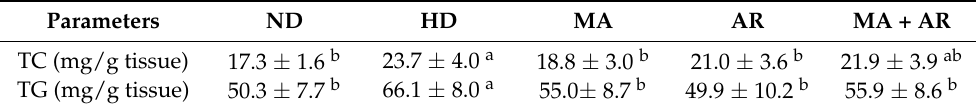
Table 3. The effect of MA, AR on hepatic lipids in the experimental mice.